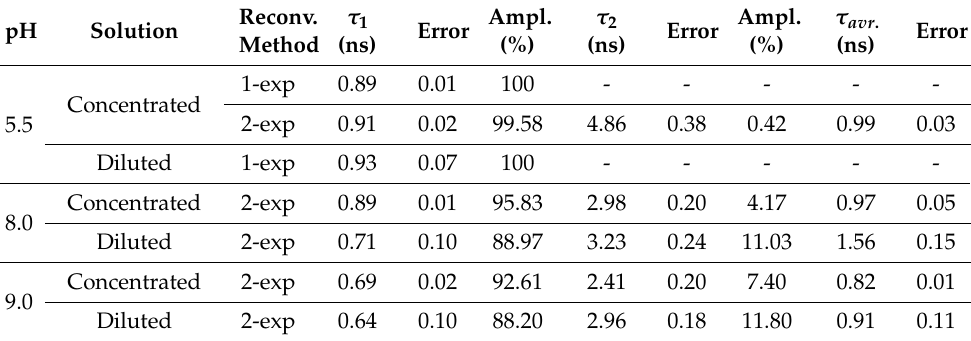
Table 2. The parameter fits (fluorescence lifetime components, errors, relative amplitude, and ampli- tude average lifetime) calculated using the reconvolution method for the concentrated, respectively diluted, solutions at both pH values.